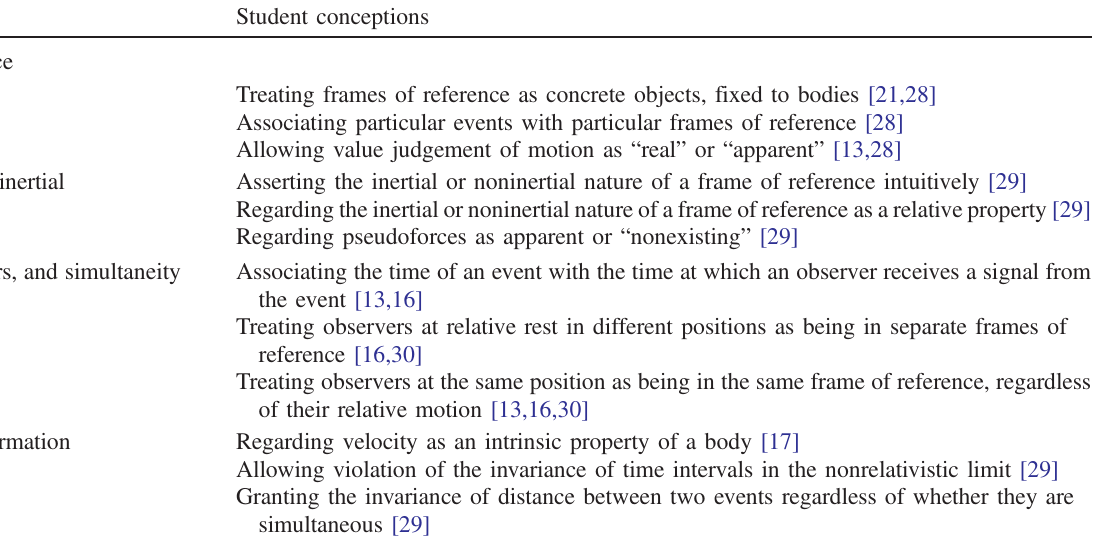
TABLE I. An overview of learning difficulties organized into three main categories and eight